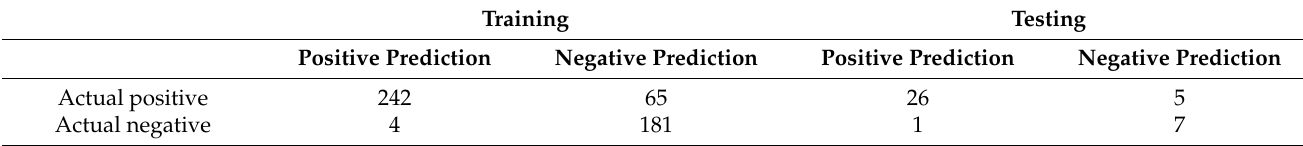
Table 5. The confusion matrix of the training and testing sets. There were 492 samples in the training set. True positive (TP) is 242; true negative (TN) is 181; false positive (FP) is 4; false negative (FN) is 65. In the testing set, there was a total of 39 samples. TP is 26; TN is 7; FP is 1; FN is 5.